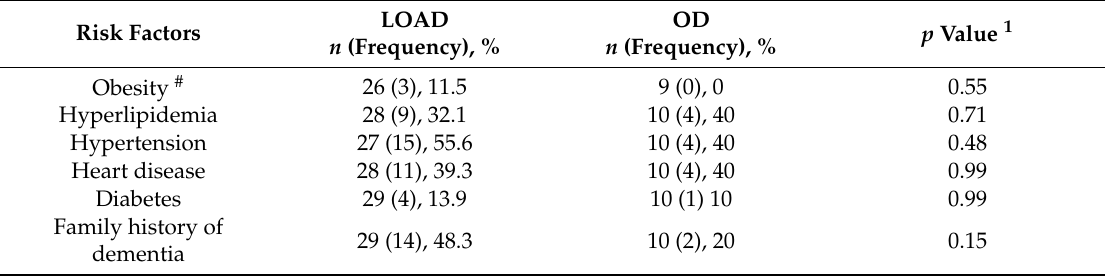
Table 2. Risk factors in late-onset Alzheimer’s disease (LOAD) and other dementia (OD)